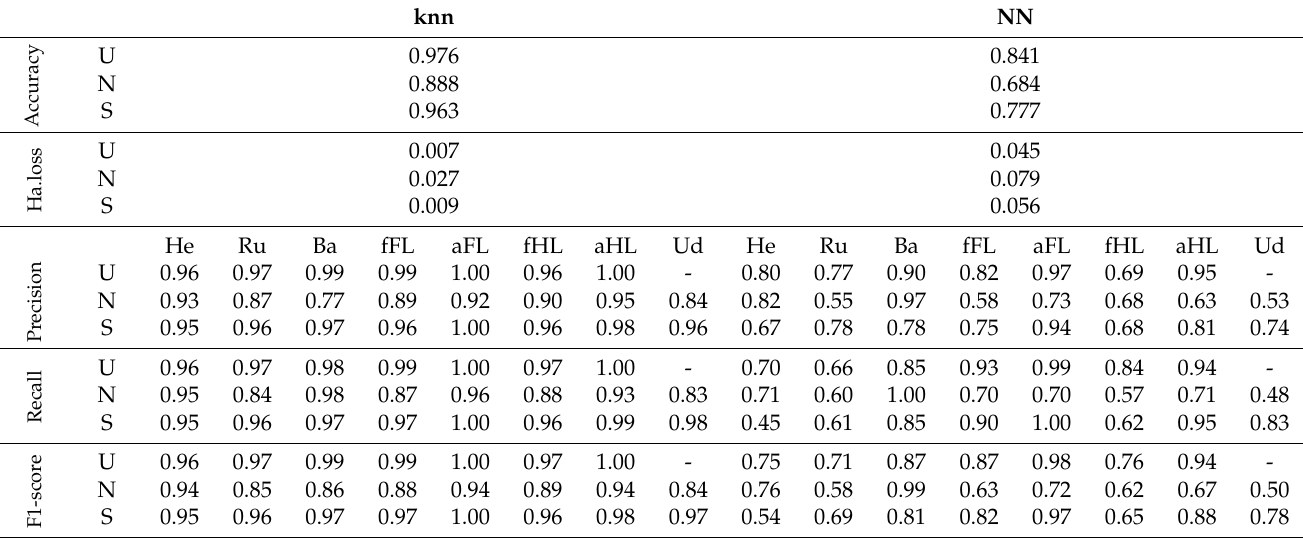
Table 3. Evaluation metrics for the methods kNN classification and neural network classification (NN). Accuracy and Hamming loss (Ha.loss) were calculated for all classes together, while Precision, Recall and F1-score were calculated separately for the body parts head (He), rump (Ru), back (Ba), facing foreleg (fFL), averted foreleg (aFL), facing foreleg (fHL), averted hindleg (aHL) and udder (Ud) using the ‘one versus rest’ approach. knn